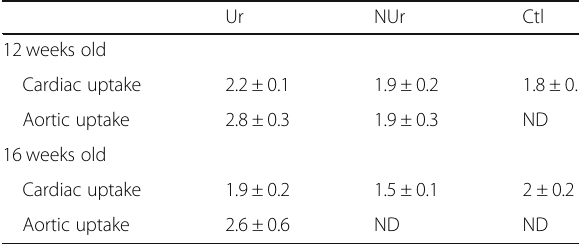
Table 2 [18F]NaF cardiac and aortic uptake quantification